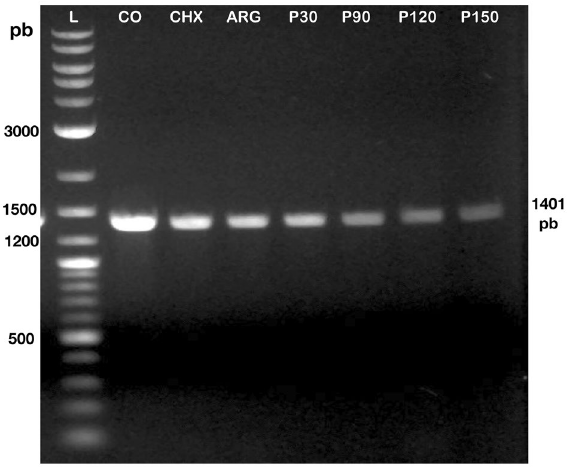
Figure 5. Agarose gel electrophoresis showing genomic DNA of S. mutans and PCR-amplified products of experimental